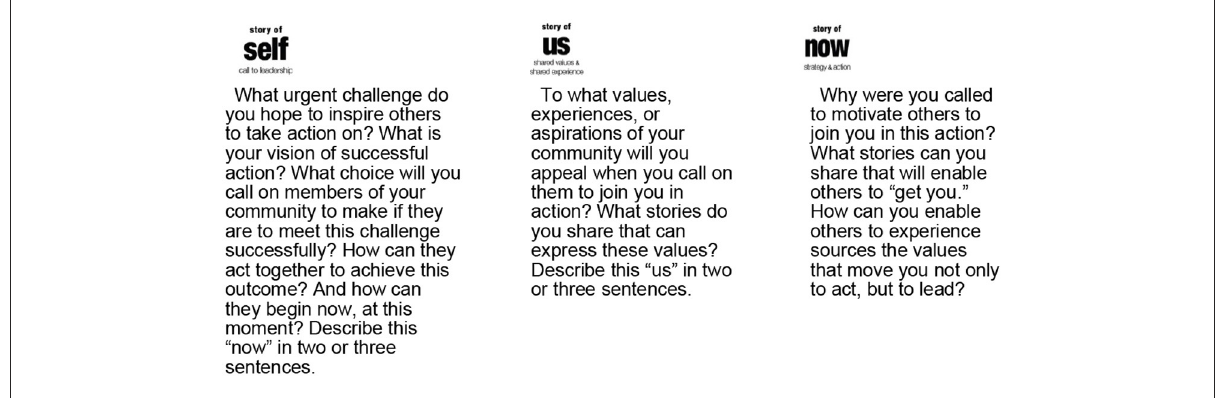
FIGURE1 What is Public Narrative: Self, us &